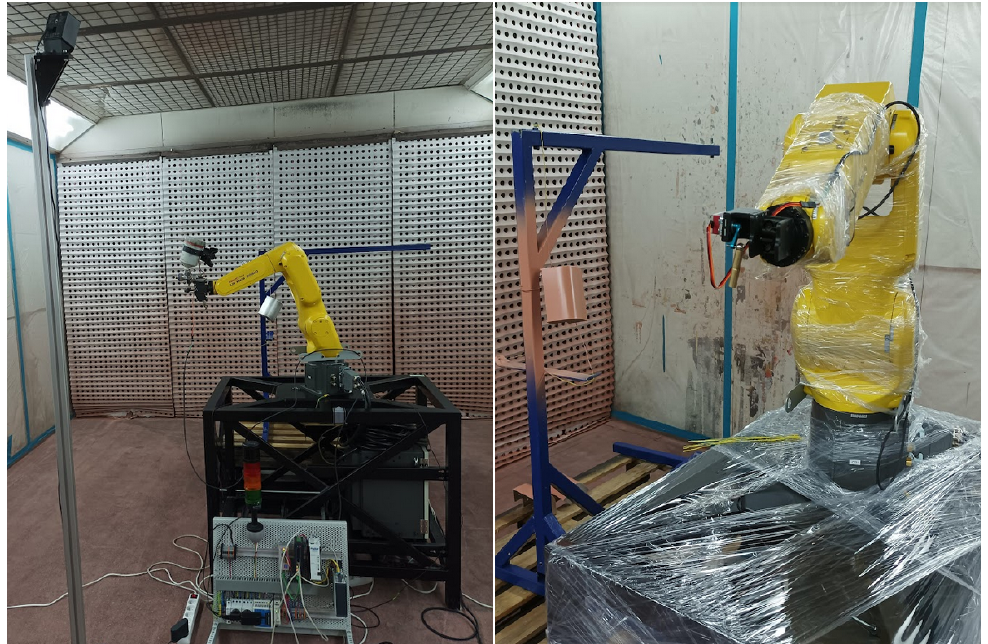
Figure 14. Pilot application—flexible spray coating robotic cell, ( left ) Fanuc LRMate 200iD robotic arm equipped with the tracking system, ( right ) detailed